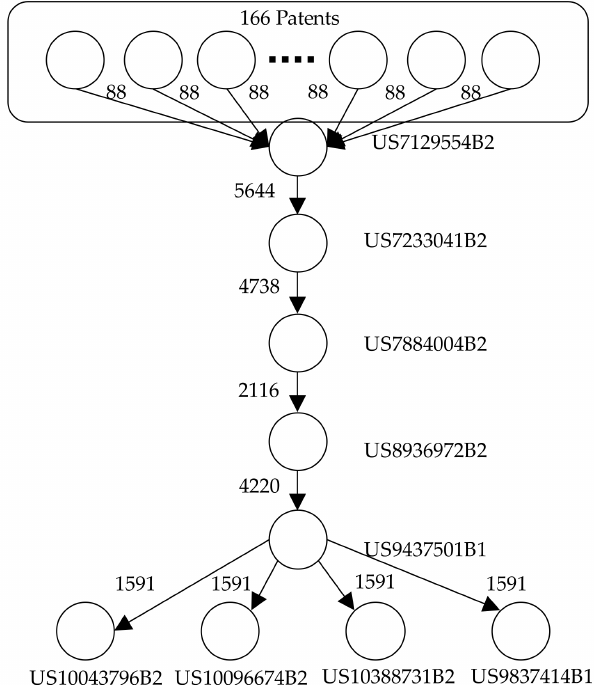
Figure 4. Global main path of 175